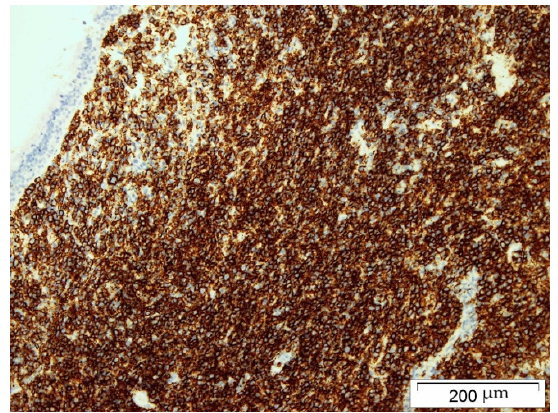
Figure 4. Tumor biopsy: HE staining.